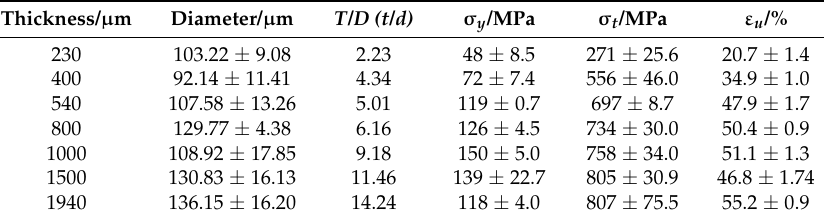
Figure 5. ( a ) True stress-strain curves of various thickness plates (the inset showing the tensile test sample.); and ( b ) yield strength and tensile strength with T / D (the insert showing the yield strength curves with average grain diameter). Table 1. Experimental results of tensile tests.